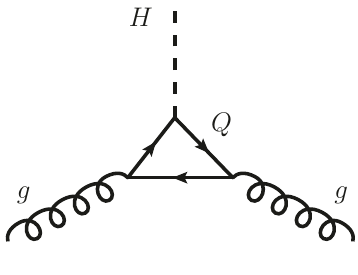
Figure 8 . Triangle diagram contributing to H → gg . Q indicates a heavy quark, Q = c, b, t . For the final contribution one needs to add an analogous (cross) contribution with the gluons interchanged (or, equivalently, reversed quark momenta in the